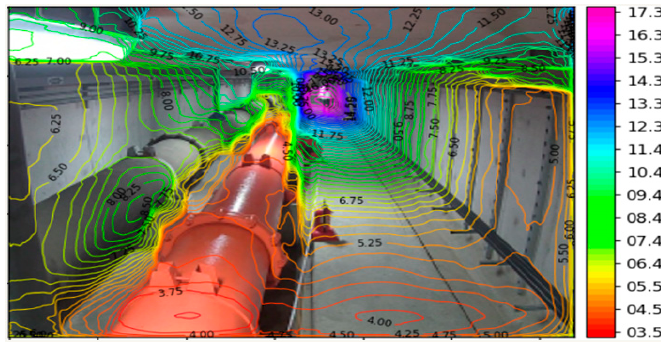
Figure 5. Extraction image of utility tunnel depth value.